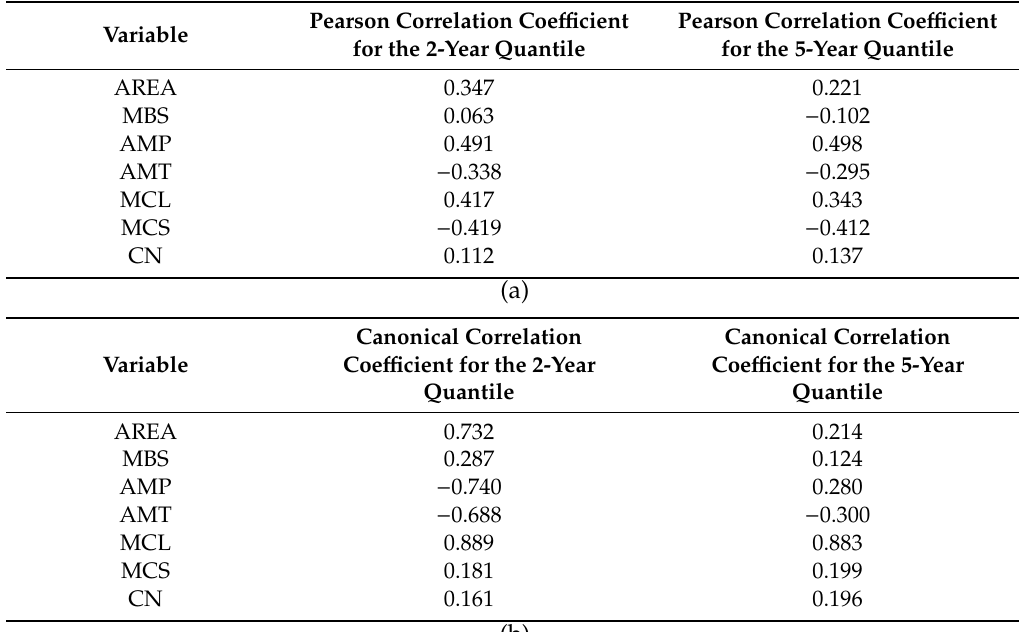
Table 3. (a) Pearson correlation coe ffi cient for the 2-year quantile and the 5-year quantile based on the variables, and (b) canonical correlation coe ffi cient for the 2-year quantile and the 5-year quantile based on the